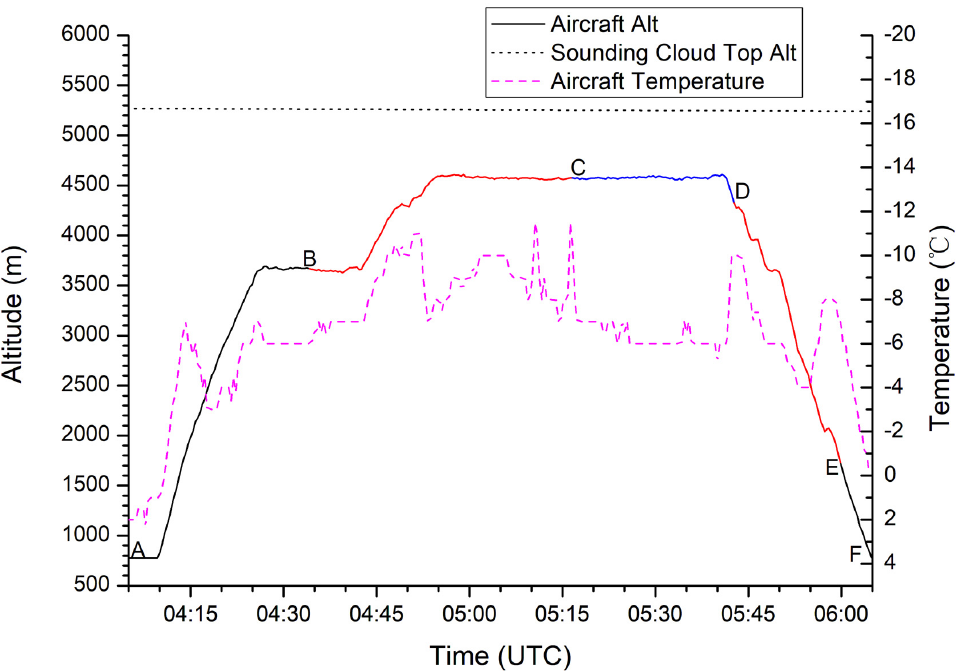
Figure 8. Evolution of flight height (black, red, and blue solid lines) and temperature (purple dotted line) from the aircraft and the cloud top altitude (black dotted line) from sounding on November 29, 2019. The black AB and EF segments represent airborne CIP data that are not matched well with satellites; the red BC (04:34–05:17 UTC) and DE (05:42–05:59 UTC) segments are compared with the satellite; and the blue CD (05:17–05:42 UTC) segment is a lack of measurement. Due to the difference in spatial resolution between satellite and aircraft measure- ments, for each satellite granule corresponding to a different scanning period, a segment of the CIP cloud particle image data is selected on the airborne detection track (black dashed line in Figure 9). At the same time, the corresponding FY-4A is identified as a single phase (red solid line in Figure 9) were selected for validation. Therefore, the cloud phase retrieved from the FY-4A satellite can be validated against that of the in-situ aircraft